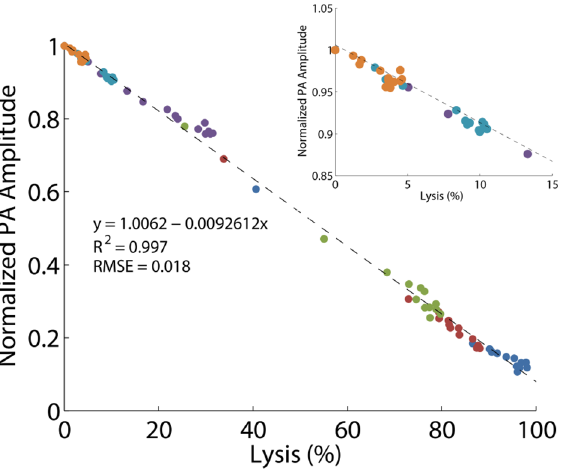
Figure 3. A crossplot of lysis percentage and normalized PA amplitude of the samples of all six osmolarities. Same colour code is followed as in Fig. 2. All the datapoints are fitted using a common trendline, which is a straight line in nature. It indicates that, independent of the tonicity of the environment, the variation in PA amplitude with lysis would follow a single straight line. This line can be used as the calibration curve to estimate the percentage of lysis by using the PA amplitude of the sample acquired using the present setup. In set, an enlarged version is presented within the lysis level of physiological